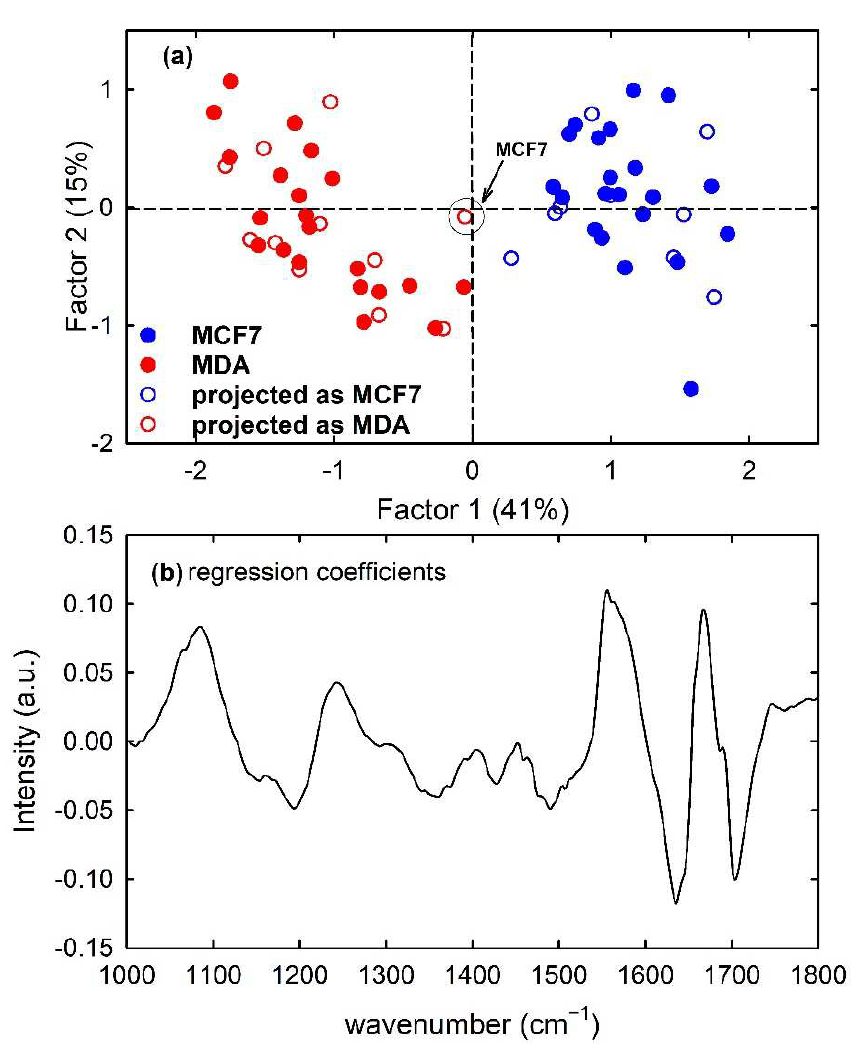
Figure 10. Scores plot (Factor 2 vs. Factor 1) of the developed PLS-DA model about FTIR spectra for MCF7 (blue circles) and MDA (red circles) cells, showing the calibration (filled circles) and projected test set (hollow circles) samples in ( a ). The root mean square error for cross-validation (RMSECV) is 0.31. One misclassified sample of the test set is enclosed inside a circle and labelled in ( a ). Regression coefficients for the PLS model with two components in ( b ).